Question: What does this figure show? Answer in one sentence.
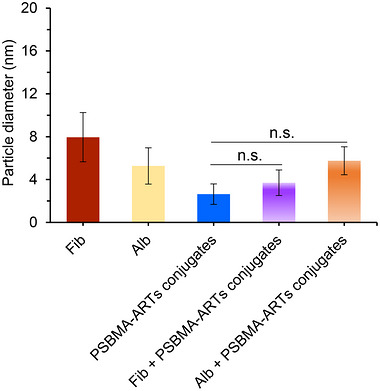
Answer: Protein antifouling property of PSBMA‐ARTs conjugates. Albumin and fibrinogen are indicated as Alb and Fib. Both data are shown as the mean ± SD ( n = 10). Statistical significance was measured between two groups using unequal variances Welch's t‐test.